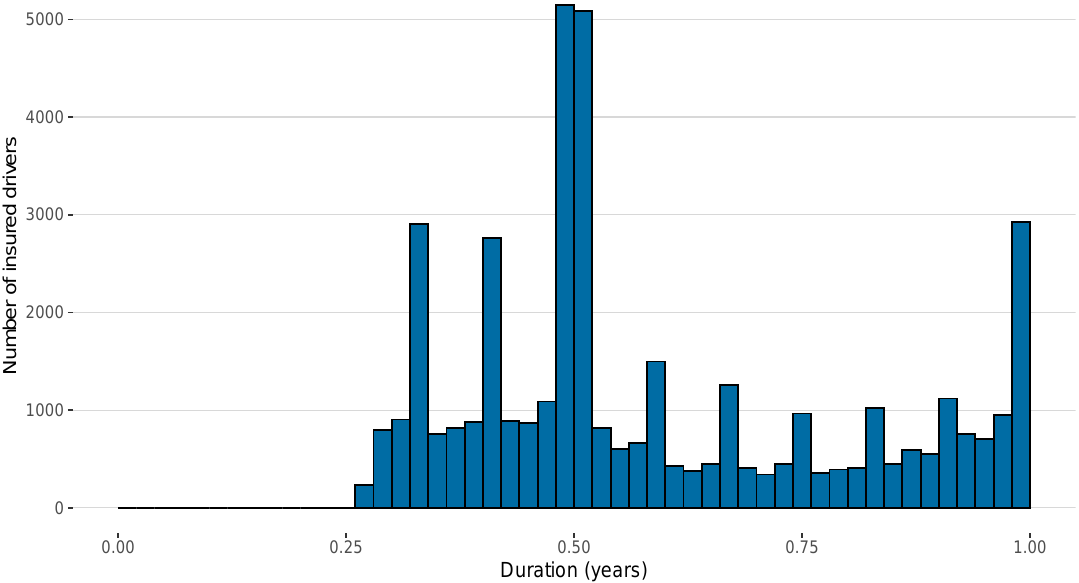
Figure 1. Histogram of risk exposure (in years) Each band has a length of 0.02